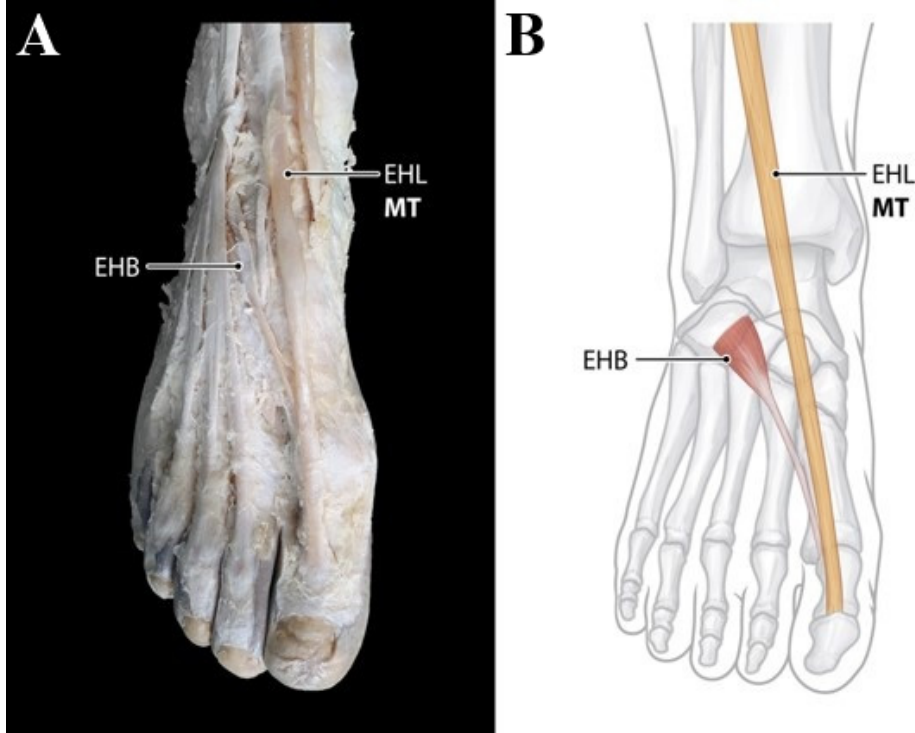
Figure 2. ( A ) Photo of Type 1 EHL tendon variation. The main single tendon inserts to the base of distal phalanx of the big toe. ( B ) Schematic drawing of Type 1 EHL tendon variation. EHB, extensor hallucis brevis tendon; EHL, extensor hallucis longus tendon; MT, main tendon. Type 3 (triple insertions) consists of three tendons including main tendon and two accessory tendon The main tendon inserts as in Type 1; with the following subtypes divided according to the different insertion of the accessory tendons. Type 3 was observed in the 3 feet (1.9%). Subtype 3B and 3C described in the classification by Zielinska et al. were observed in the 1 foot (0.6%), respectively. Subtype 3B showed that two accessory tendons arise from the medial side of the main tendon and insert into the capsule of first metatarsophalangeal joint, whereas two accessory tendons arise from the medial and lateral side of the main tendon and insert into the capsule of first metatarsophalangeal joint in Subtype 3C (Figure 4A–D). However, Subtype 3A was not observed in our study. In addition, it is noteworthy that new subtype not mentioned in the classification by Zielinska et al. was founded in 1 foot (0.6%) of our study. In the subtype named ‘3K’, the two accessory tendons arise from the lateral side of the main tendon and insert into the capsule of first metatarsophalangeal joint (Figure 4E,F). The significant difference regarding the distribution of types can be found between gender ( p = 0.016) which is presented in Table 1. However, there was no significant difference in the distribution of types between the left and right ( p = 0.205) (Table